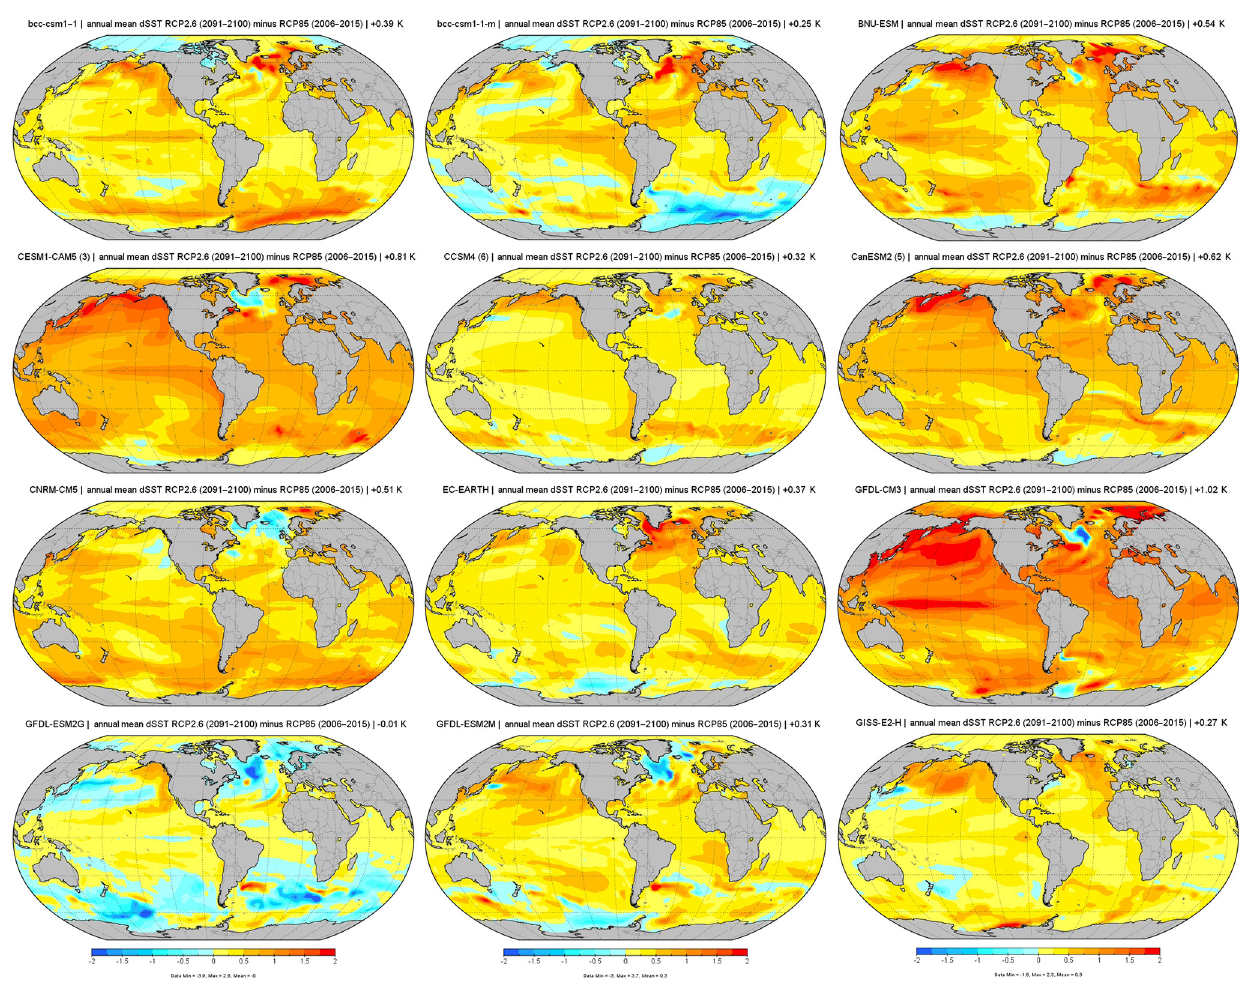
Figure A1. As in the 1.5 ◦ experiment delta SST pattern in Fig. 3 but for the first set of 12 individual